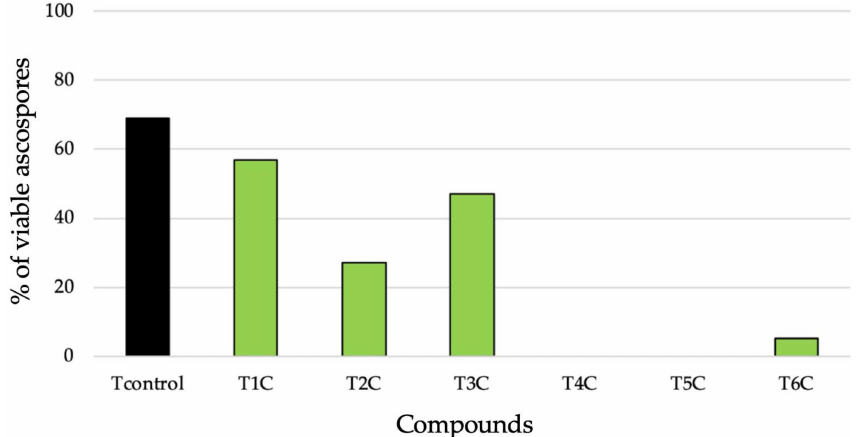
Figure 4. Percentage of viable ascospores after subjecting chasmothecia to treatments with the following compounds: distilled H 2 O (Tcontrol), chitosan oligomers (T1C), COS + silver nanopar- ticles (T2C), COS + ε -polylysine (T3C), COS + Streptomyces rochei secondary metabolites (T4C), COS + S. lavendofoliae secondary metabolites (T5C), and COS + hydrolyzed gluten